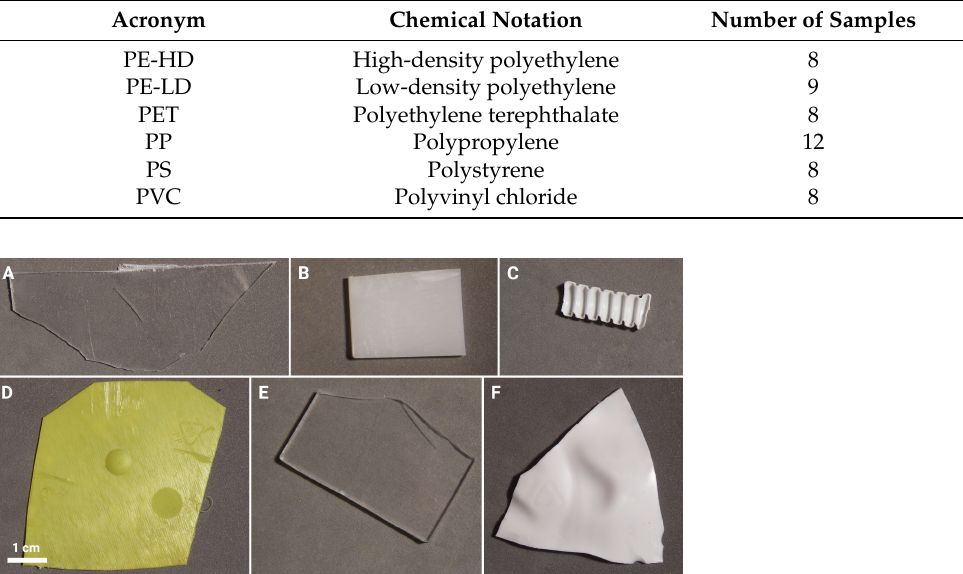
Figure 2. Photos of exemplary plastic samples, where ( A ) is PS, ( B ) is PE-LD, ( C ) is PVC, ( D ) is PP, ( E ) is PET, and ( F ) is